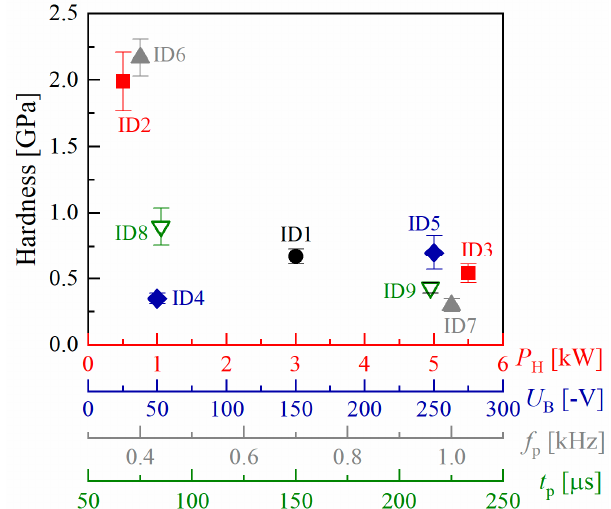
Figure 7. Dependence of the hardness of the HiPIMS MoS x films on the heating power P H and bias-voltage U B , for f p = 0.7 kHz and t p = 150 µs, as well as the pulse frequency f p and pulse duration t p , for P H = 3 kW and U B = − 150 V. Table 3. Mechanical properties (hardness H and Young’s modulus E ) and friction coefficient µ of the MoS x films using the uncoated or MoS x -coated 100Cr6 counter body (cb).